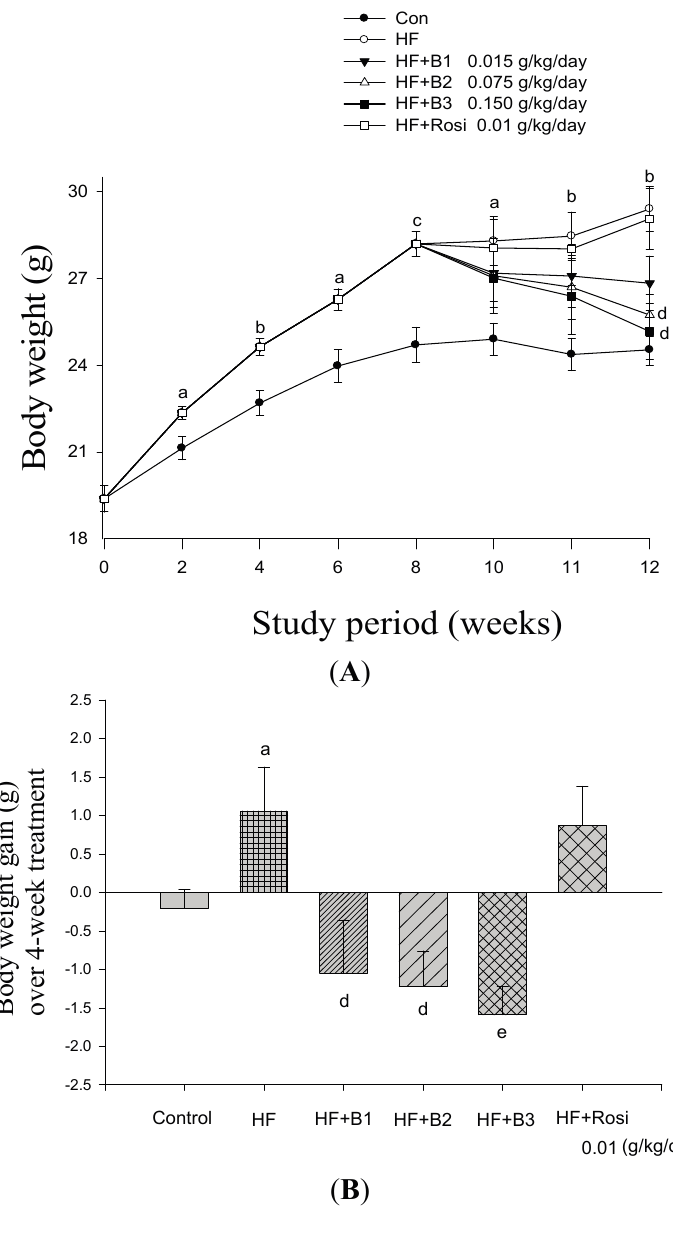
Figure 2. Effects of Bofu-tsusho-san (BO) on ( A ) body weight; ( B ) body weight gain; ( C ) glucose levels at week 10 and 12 and ( D ) plasma triglyceride level at week 12. Mice were fed with 45% high-fat diet (HF) or low-fat diet (CON) for 12 weeks. After 8 weeks, the HF mice were treated with vehicle, or B1, B2, B3, extract granules of BO (0.015, 0.075 and 0.150 g/kg body weight), or rosiglitazone (Rosi) (0.01 g/kg body weight) or vehicle accompanied with HF diet for 4 weeks. Visceral fat: EWAT + RWAT; EWAT, epididymal white adipose tissuel; RWAT: retroperioneal white adipose tissue. All values are means ± S.E. ( n = 9). a p < 0.05, b p < 0.01, c p < 0.001 compared with the control (CON) group; d p < 0.05, e p < 0.01, f p < 0.001 compared with the high-fat + vehicle (distilled water) (HF) group by